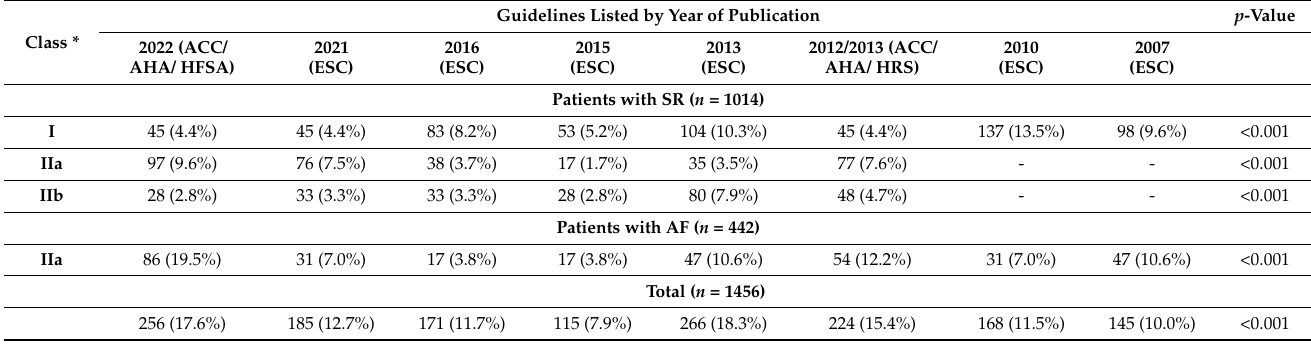
Table 2. The changes in eligibility for CRT of real-life patients with heart failure according to differences in the last fifteen-years international guidelines.